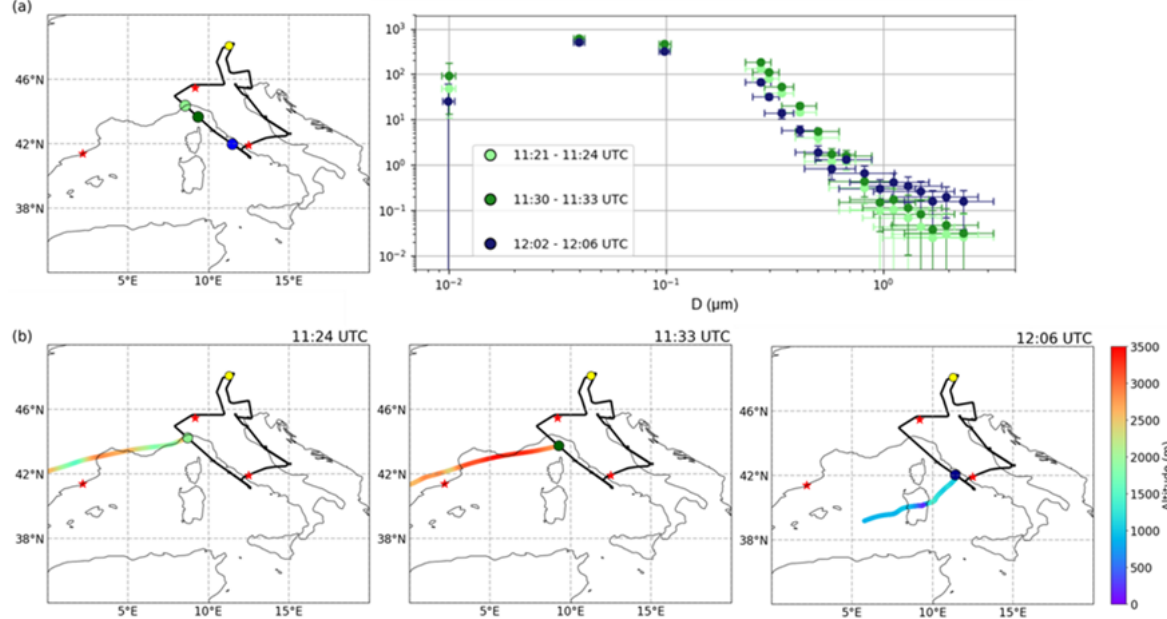
Figure 29. Example of the effect of dust plumes on the aerosol concentration during E-EU-03 on the 11 July 2017. (a) Particle size distribution for three selected time periods (right) and position of the sample points in the flight track (left). The error bars on the y axis are the standard deviations of the mean measured concentrations. The error bars in x direction indicate the 16th and 84th percentile of the median diameters of the sensitivities of each size channel; (b) 48h backward trajectories for the three periods selected. The red stars and the yellow dot indicate the position of the MPCs of interest and of the HALO base (OP), respectively.